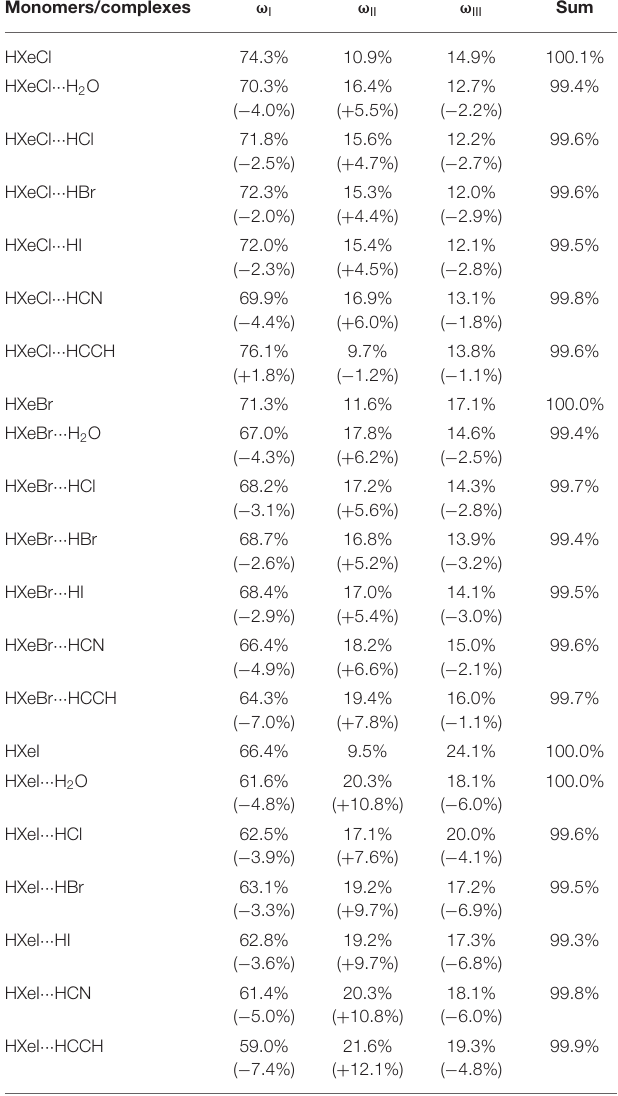
TABLE 1 | The weighting and its change of three resonance structures (H-Xe + :Y − , H: − Xe + -Y, H ∧ Y) upon HXeY complexation with H 2 O/HCl/HBr/HI/HCN/HCCH, compared with the monomer HXeY.